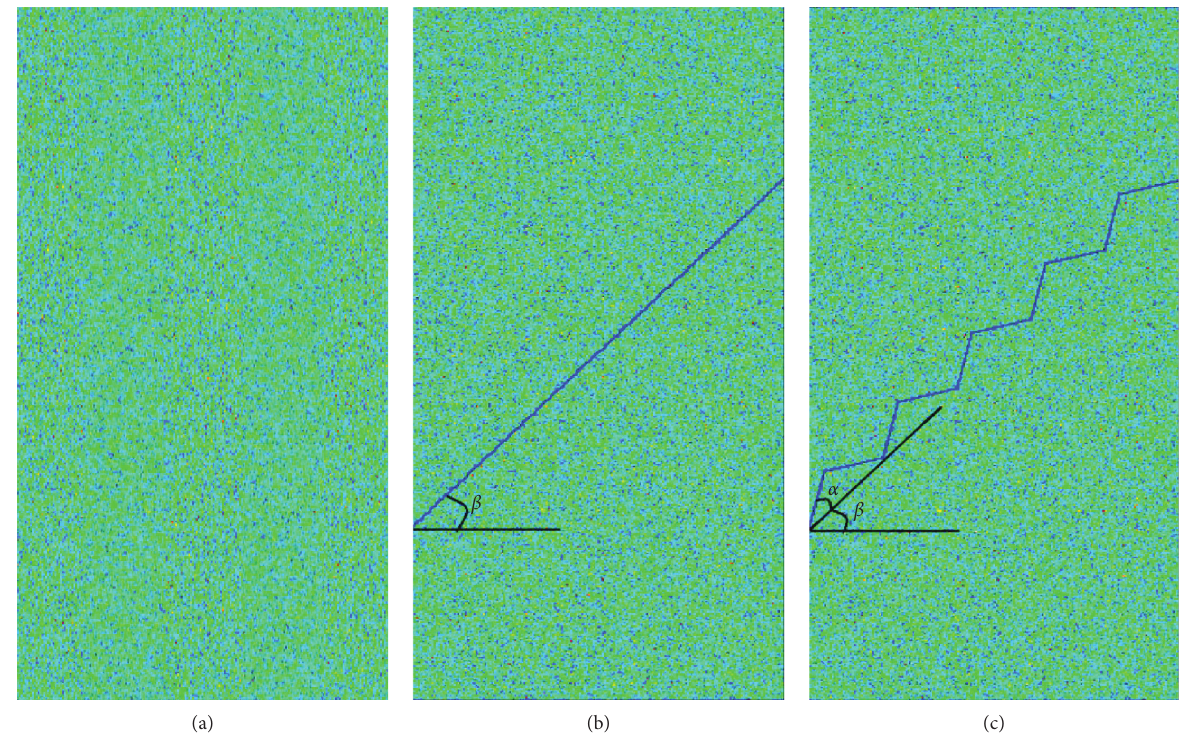
Figure 3: Three numerical specimens’ models. (a) Numerical specimen A, (b) numerical specimen B, and (c) numerical specimen